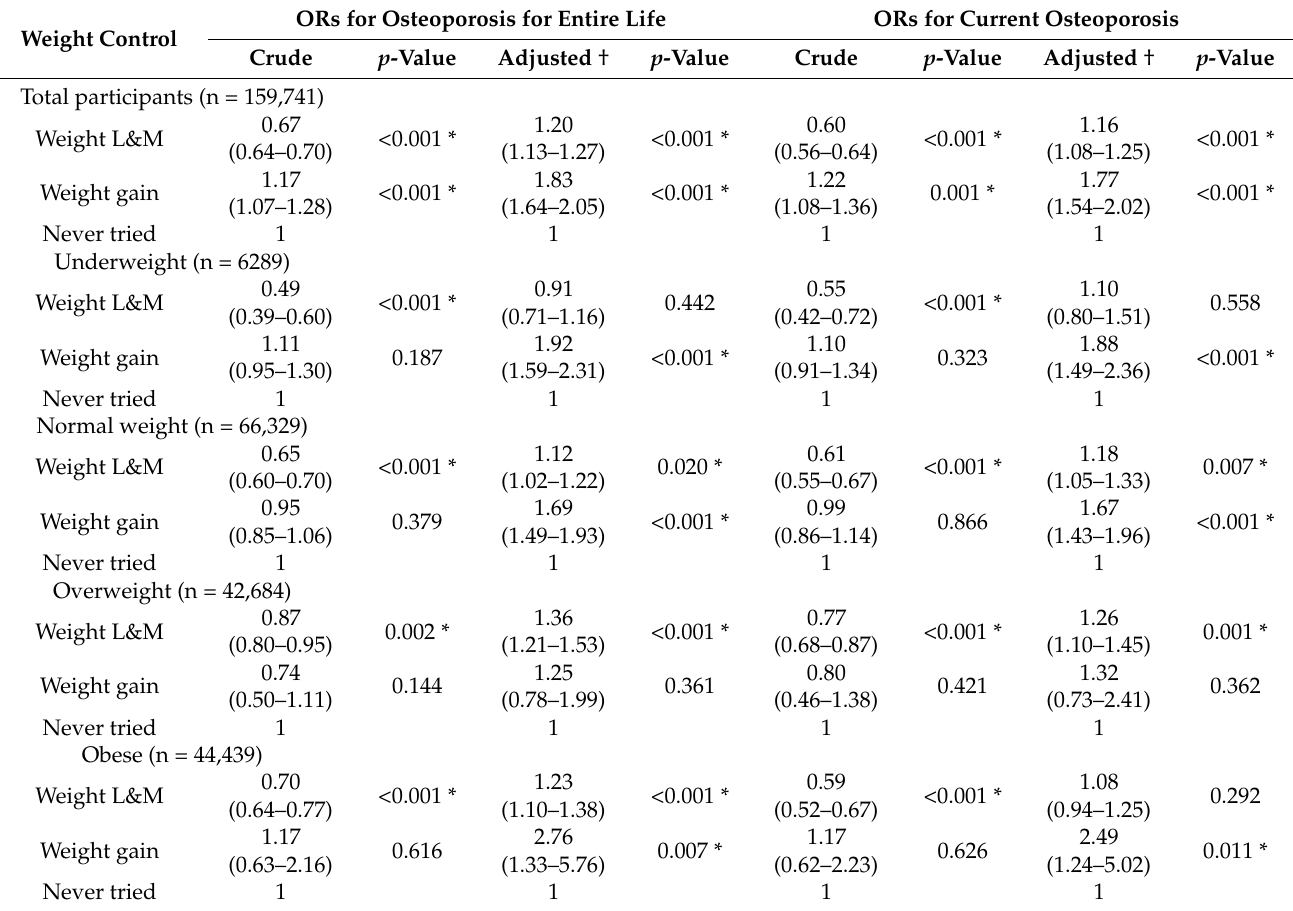
Table 2. Crude and adjusted odd ratios (95% confidence interval) of weight control for